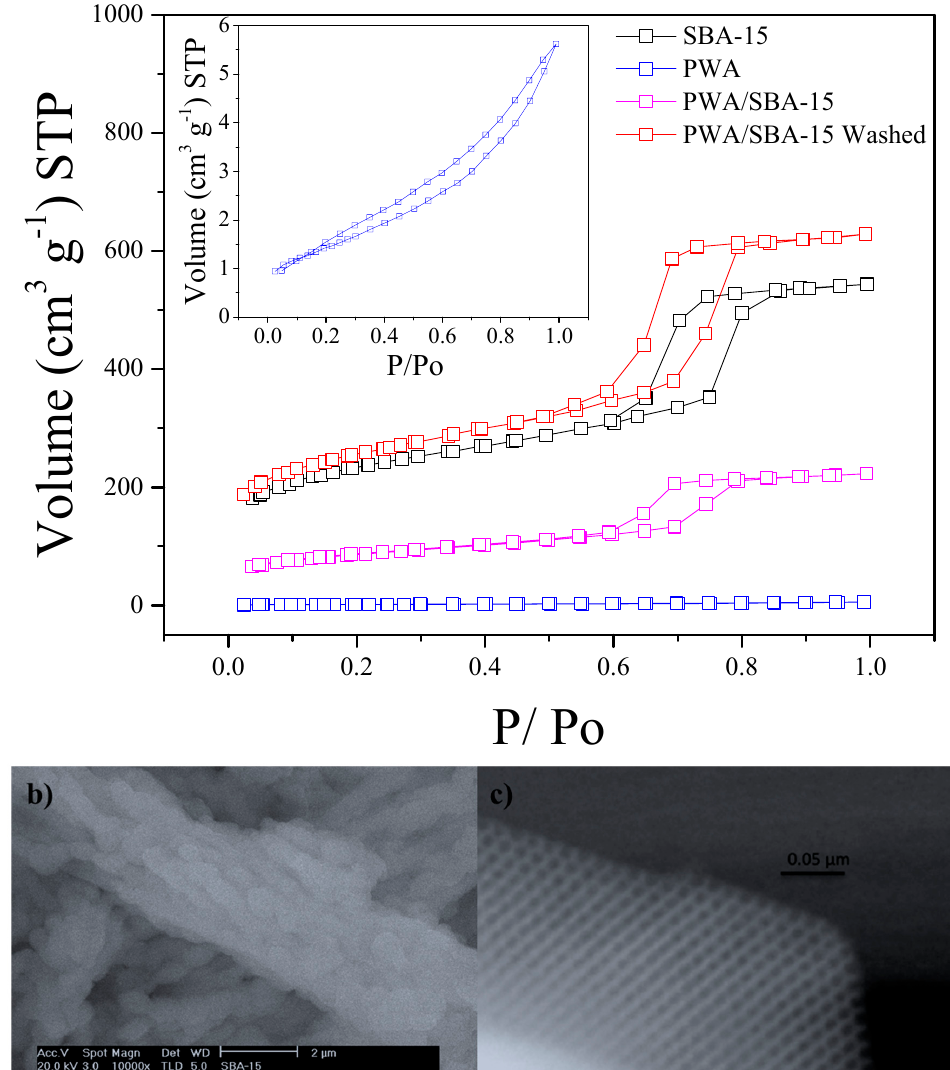
Figure 2. ( a ) Adsorption / desorption isotherms of inorganic fillers; ( b ) SEM morphology of SBA-15; ( c ) Figure 2. a ) Adsorption / desorption isotherms of inorganic fillers; b ) SEM morphology of SBA-15; c ) HRTEM image of SBA-15. HRTEM image of Table 1. Textural properties of inorganic fillers.